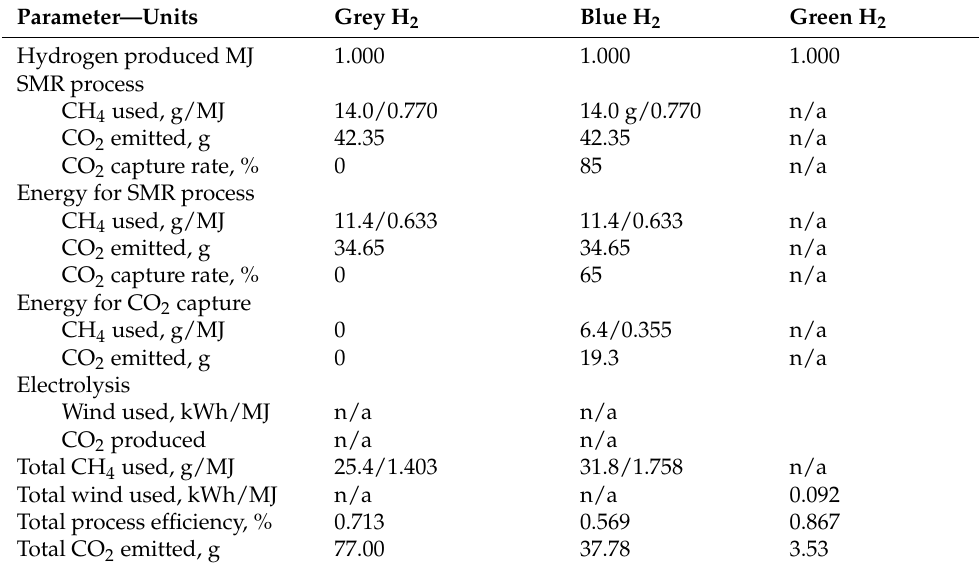
Table 1. Energy use and carbon dioxide emissions for the production of one megajoule of either grey or blue hydrogen from methane and of green hydrogen from water and wind